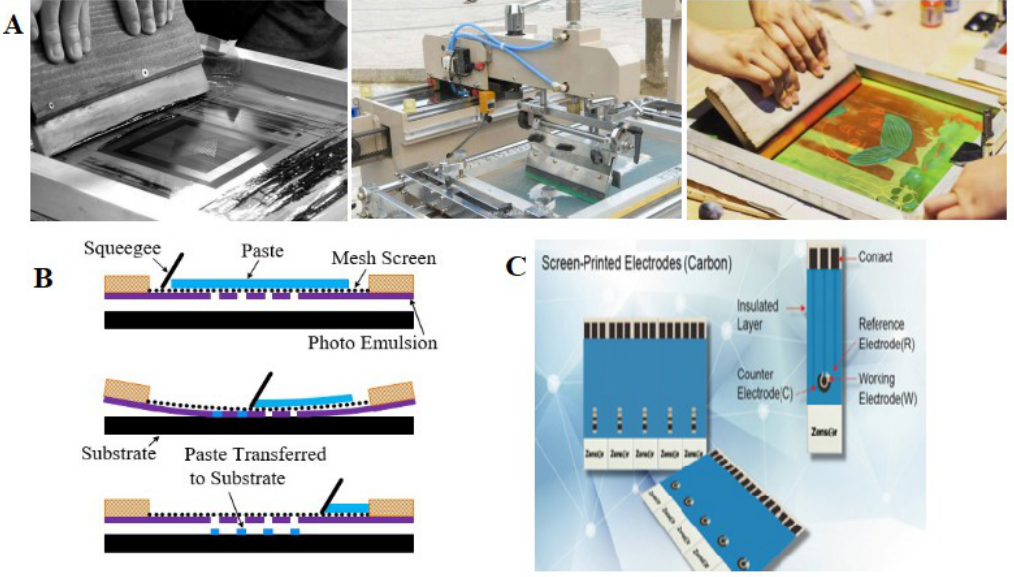
Figure 3. Microfluidic chip based on screen-printing: ( A ) the Screen-printing device; ( B ) the principle of screen-printing; ( C ) the screen-printed electrodes.